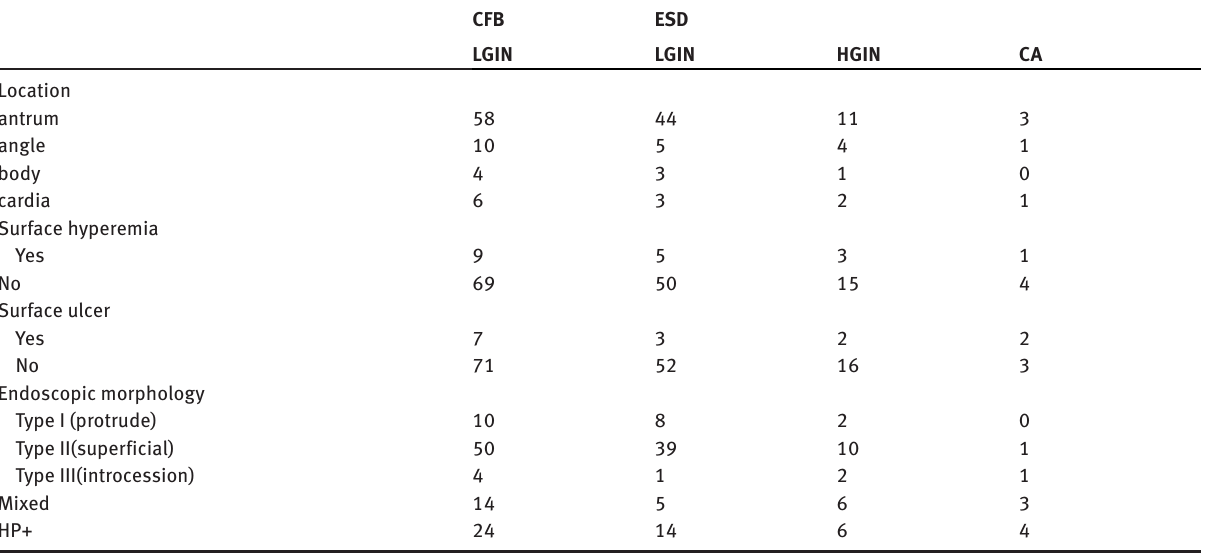
Table 1: Characteristic of 78 LGIN patients under